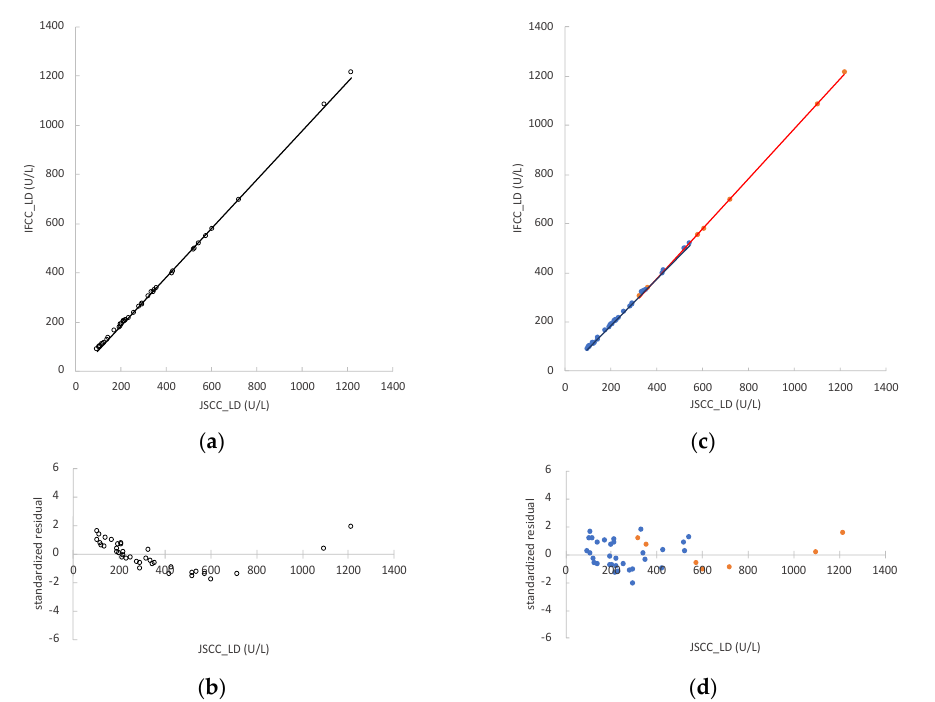
Figure 1. Correlation between lactate dehydrogenase (LD) activity measured by the Japan Society of Clinical Chemistry (JSCC) and International Federation of Clinical Chemistry and Laboratory Medicine (IFCC) methods in mouse serum samples. The x-axes represent values obtained by the JSCC method and the y-axes represent those obtained by the IFCC method: ( a ) regression analysis comparing the JSCC and IFCC values of all samples ( n = 39), represented by the formula y = 0.990x − 12.956; ( b ) standardized residual plots obtained using the regression equation of all samples ( n = 39); ( c ) regression analysis comparing JSCC and IFCC values of non-hemolyzed samples ( n = 32, blue dots) and hemolyzed samples ( n = 7, orange dots), represented by the formulas y = 0.954x − 4.008 and y = 1.015x − 31.033, respectively; ( d ) standardized residual plots obtained using the regression equations of non-hemolyzed samples ( n = 32, blue dots) and hemolyzed samples ( n = 7, orange dots).